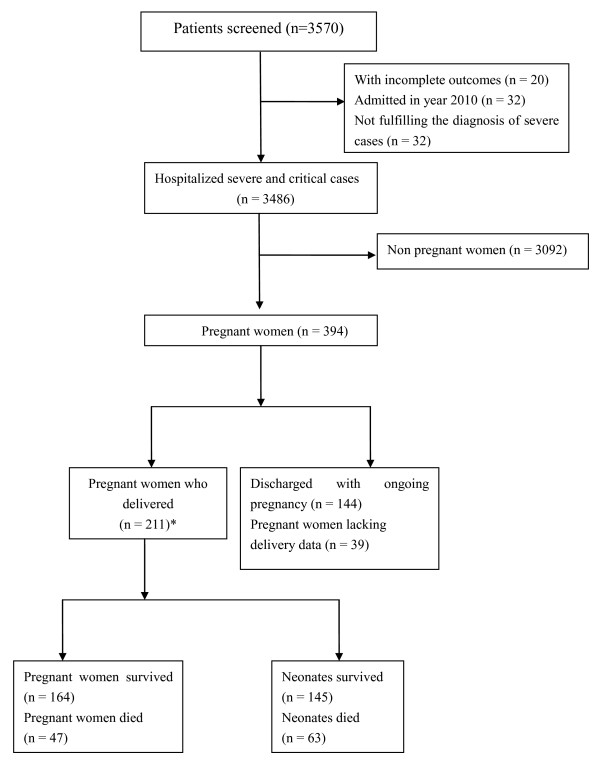
Flow chart of patients enrolled and included in the analysis * Missing data for neonatal outcomes (n = 3).